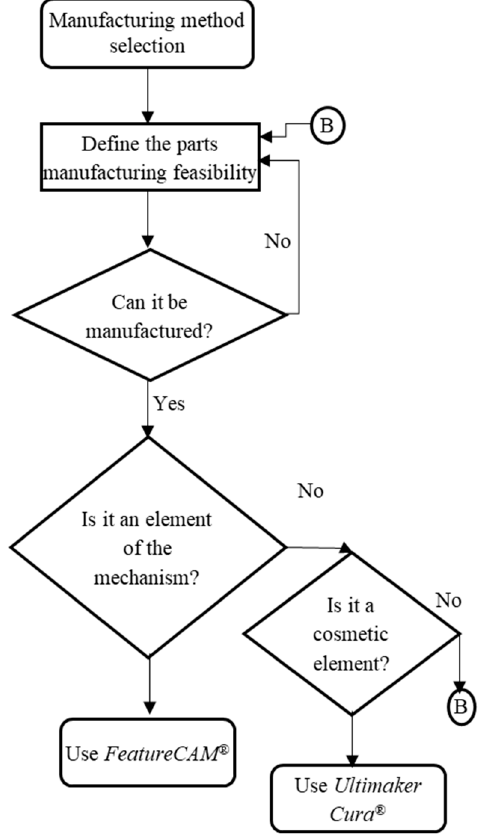
Figure 14. Selection of the manufacturing method to be used.